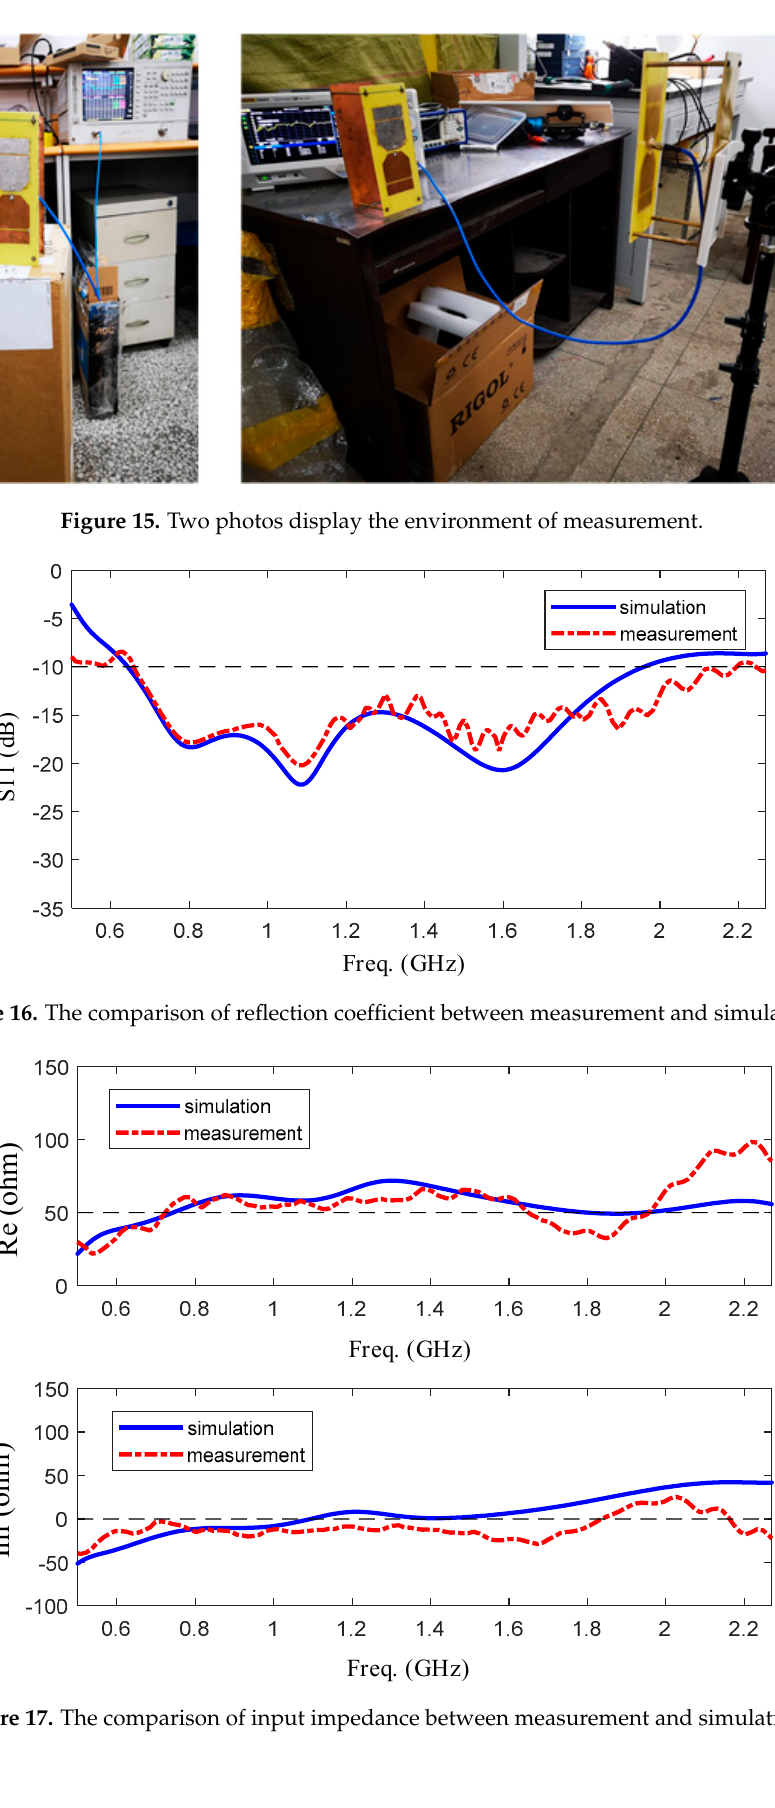
Figure 17. The comparison of input impedance between measurement and simulation.